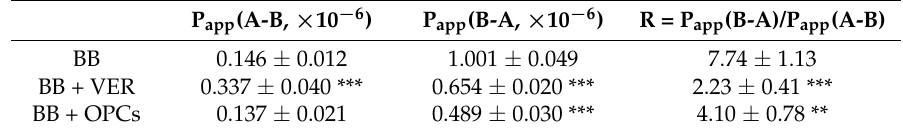
Table 1. Effects of drugs on the transport of BB across Caco-2 cell monolayers.